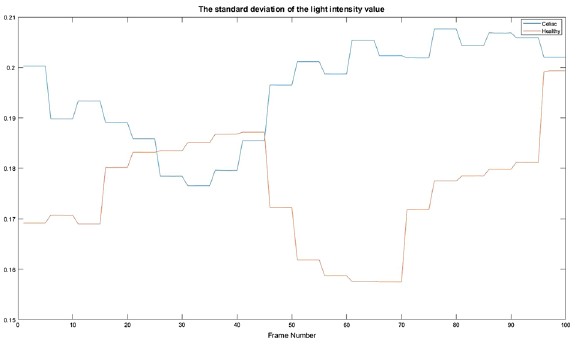
Figure 13. The standard deviation of the light intensity value. Red = Healthy and Blue = Celiac.